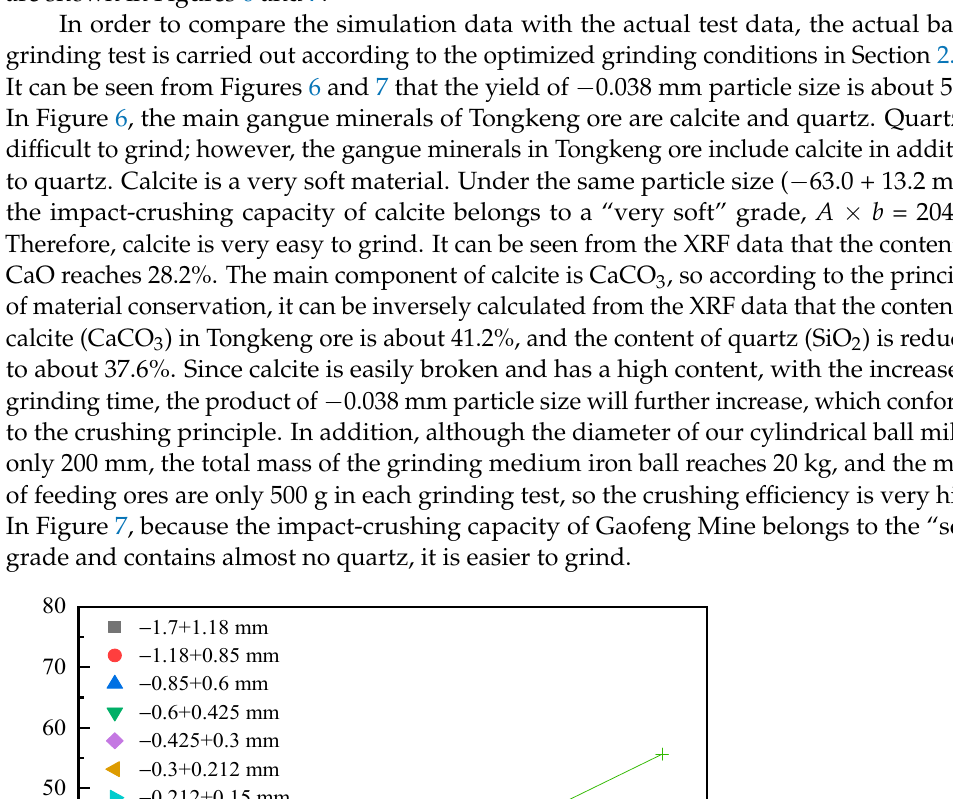
Figure 7. Product particle size composition of Gaofeng ore at different grinding times.